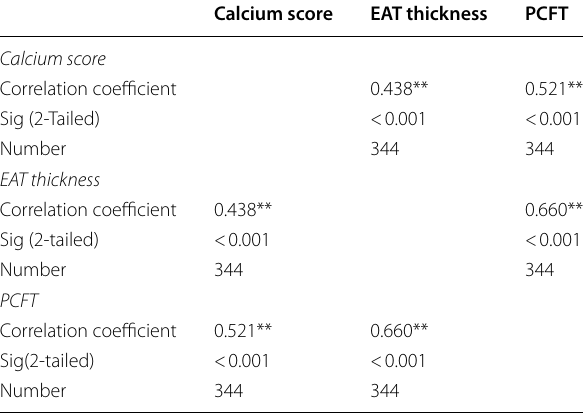
Table 3 Correlation Between EAT thickness, PCFT and calcium score